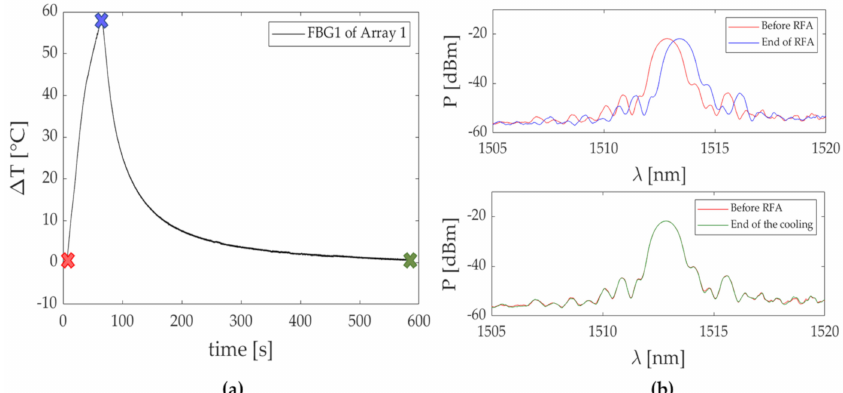
Figure 9. ( a ) Temperature trend recorded by FBG 1 embedded in Array 1 during an RF procedure on myocardial tissue; ( b ) optical spectra relative to FBG 1 recorded during the three di ff erent steps of the procedure marked as ( a ). In the upper image, the spectra collected before (red line) and at the end of the RF procedure (blue line). In the bottom image, the spectra collected before the RFA (red line) and at the end of the cooling phase (green